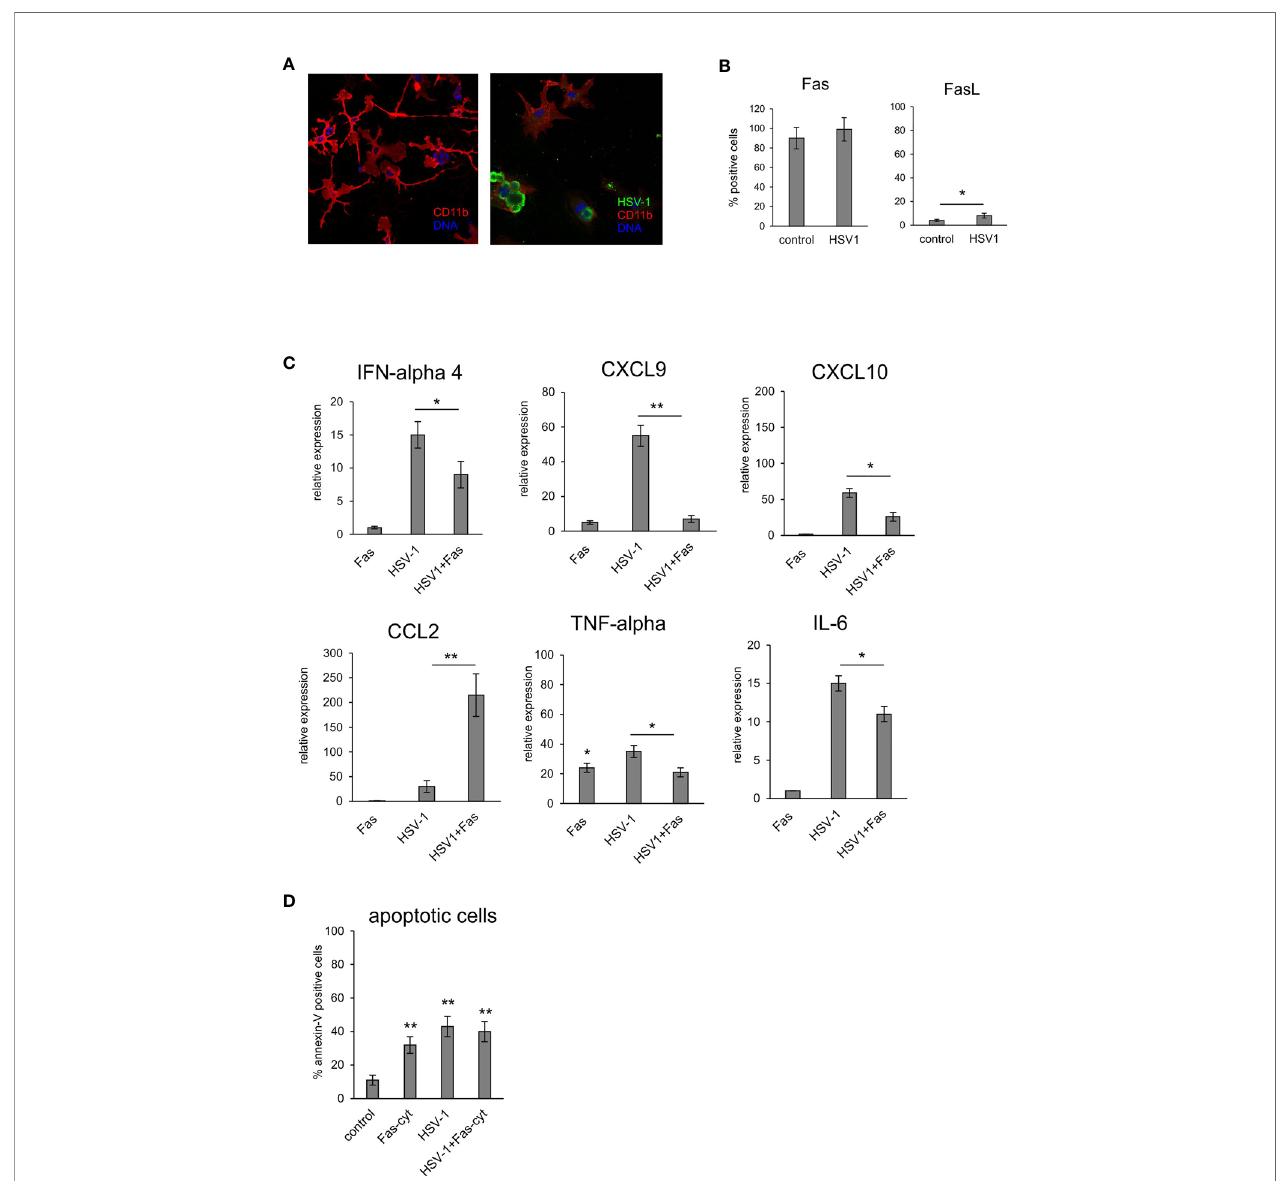
FIGURE 6 | Fas-stimulated microglia in HSV-1 infected cultures down-regulate expression of pro-in fl ammatory and antiviral cytokines. (A) Confocal microphotographs of uninfected (left) and HSV-1 infected (right) microglial cultures at 24 h p.i.; Co-immuno fl uorescent staining for HSV-1 antigens (green), IBA-1 positive microglia (red). Nuclei were counterstained with DAPI (blue). Magni fi cation x 200. (B) Fas and FasL expression on microglial cultures, uninfected and 24 h p.i. measured by fl ow cytometry. Each bar represents the mean from 3 experiments (N = 3) ± S.E.M., *represents signi fi cant differences with p ≤ 0.05. (C) Expression of IFN- a 4, CXCL9, CXCL10, TNF- a , IL-6 and CCL2 mRNA at 24 h p.i. in microglia cultures prepared from wild-type (C57BL/6) mice, Fas receptor was stimulated with recombinant mouse FasL. Data were presented as mean ± SEM, N = 4. Data analysis was performed by comparing FasL treated and untreated infected cultures. **p ≤ 0.001, *p ≤ 0.05. (D) apoptotic cells (annexin V-positive) in microglia cultures prepared from wild-type (C57BL/6) mice, Fas-dependent apoptosis was induced using recombinant mouse FasL. Each bar represents the mean from 3 experiments (N = 3) ± S.E.M., **represents signi fi cant differences with p ≤ 0.001 compared to uninfected